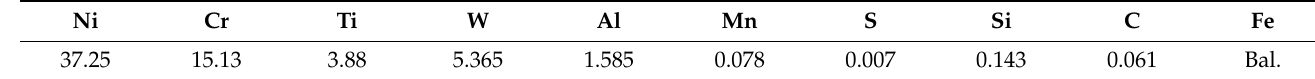
Figure 1. SEM image of K213 alloy powder. Table 1. Composition of K213 alloy powder (wt.%).